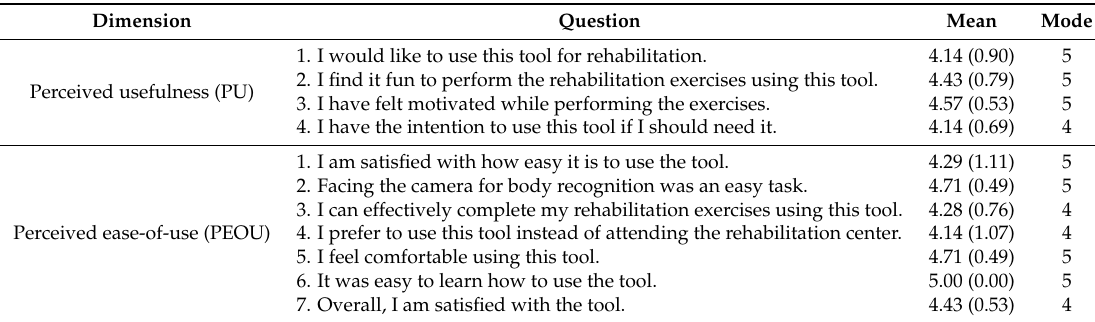
Table 1. Statistical values relating to “perceived usefulness” and “perceived ease-of-use” dimensions to scores provided by participants using the tool (1: totally disagree; 5: totally agree). Numbers in parentheses denote standard